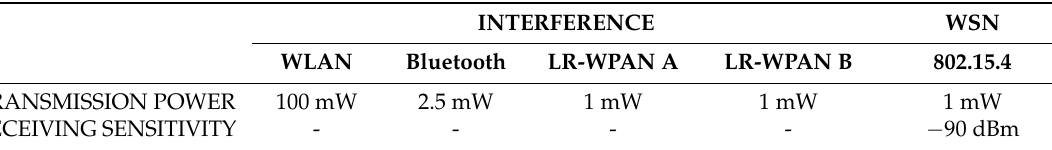
Table 2. Transmission powers and receiving sensitivities for the interfering networks and the wireless sensor network under study.